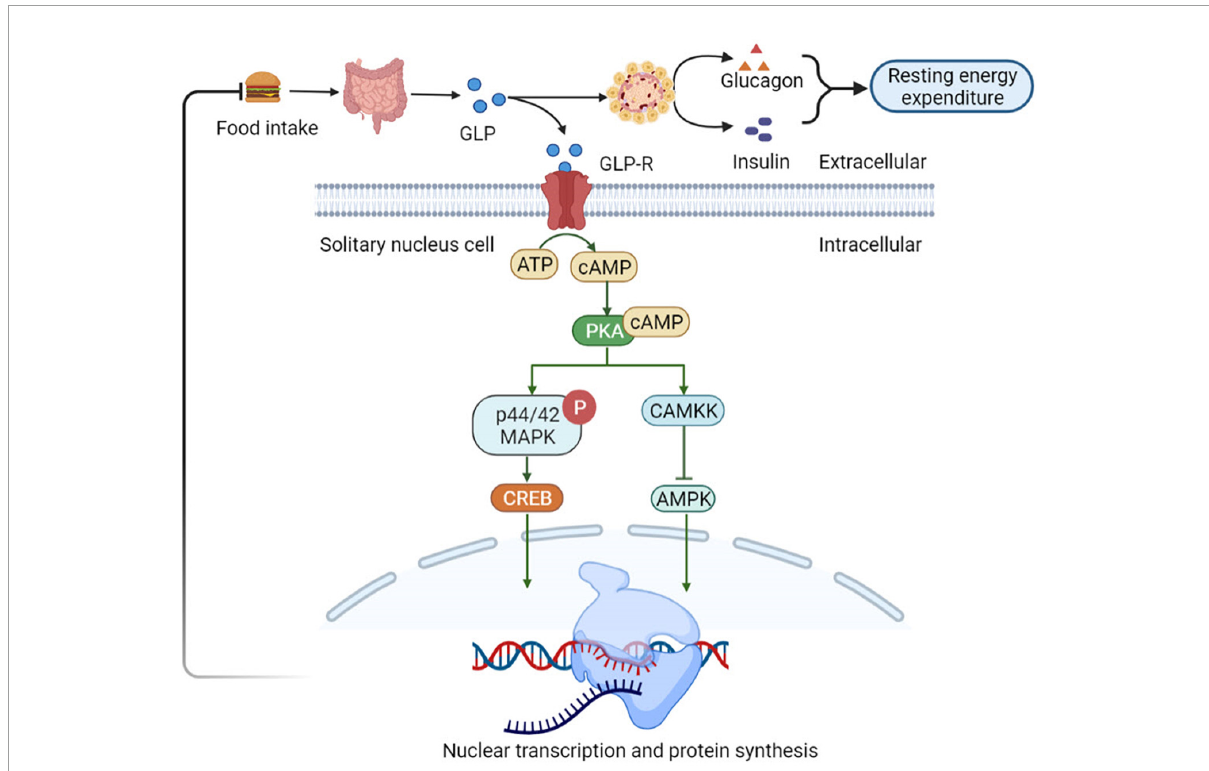
FIGURE4 Glucagon-like peptide 1 (GLP-1) regulates appetite and energy metabolism. GLP-1R-expressing neurons to initiate a cAMP-dependent increase in PKA activity, drives simultaneous phosphorylation and activation of p44/42 MAPK and inhibits CaMKK. It catalyzes the phosphorylation of Thr172 residue in the AMPK α subunit, resulting in CAMKK activity inhibition and reduced AMPK activation, which promote an elevated in CREB-mediated nuclear transcription and protein synthesis. In this way the NTS GLP-1R-expressing neurons can integrate various anorectic signals involved in meal-to-meal food intake control. NTS, nucleus of the solitary tract; PKA, protein kinase A; MAPK, mitogen-activated protein kinase; CaMKK, Ca 2 + /calmodulin-dependent protein kinase kinase; AMPK α , adenosine monophosphate protein kinase α ; CREB, cAMP response